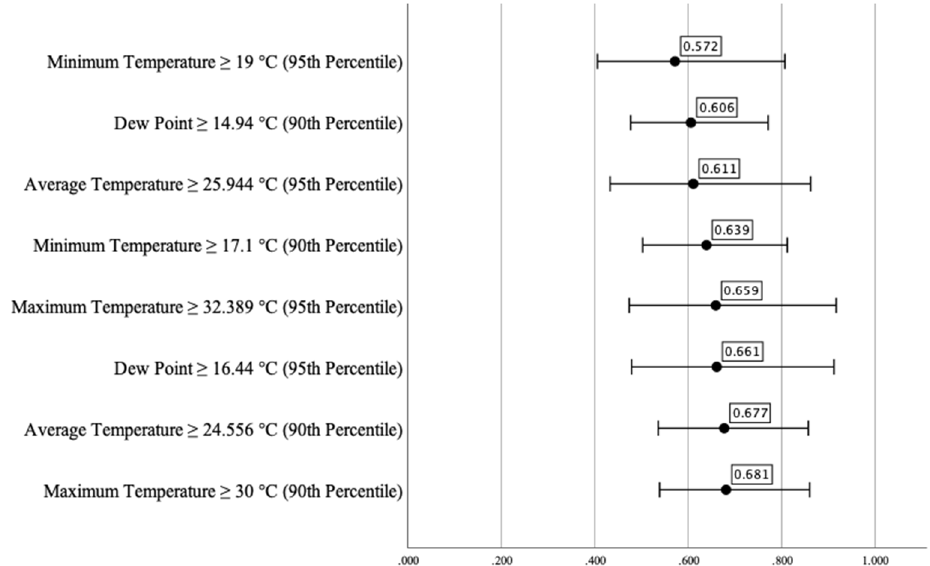
Figure 2. Risk estimation of the effect of extreme meteorological parameters on the number of COPD-related emergency visits per day, p < 0.05. Table 5. Relationship between the extreme meteorological parameters and the number of COPD- related emergency visits per day, p <